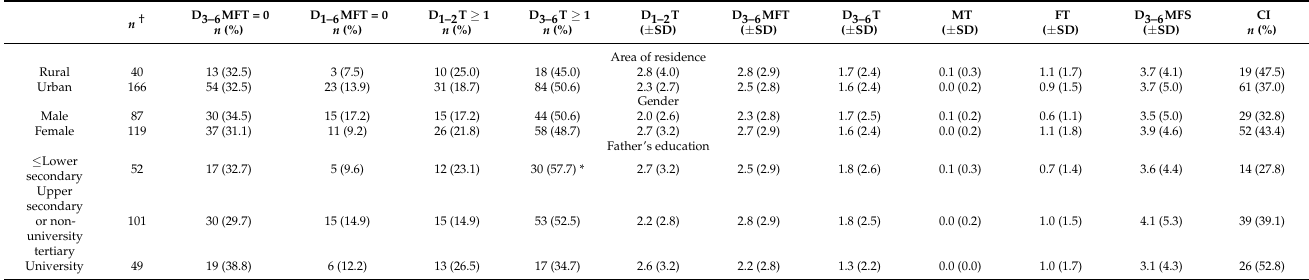
Table 3. Caries prevalence and caries experience of 15-year-old children of immigrant origin in Greece. Number of children ( n ), percentage of caries-free children on the D 3–6 MFT level (D 3–6 MFT = 0), percentage of caries-free children on the D 1–6 MFT level (D 1–6 MFT = 0), percentage of children with initial caries (D 1–2 T ≥ 1), percentage of children in need of restorative treatment (D 3–6 T ≥ 1), mean ICDAS 1–2 on the tooth level (D 1–2 T), mean D 3–6 MFT and its components (D 3–6 T, MT, FT),